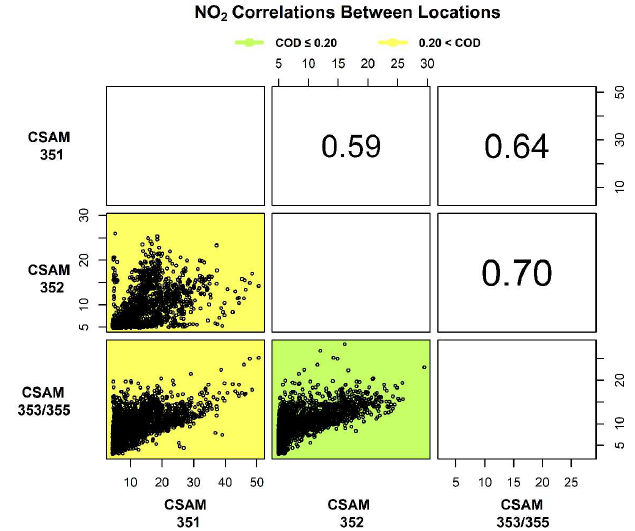
Figure 5. 1 h average NO 2 concentrations were time-aligned in pairwise manner to calculate the Person coefficient (r) and Coefficient of Divergence (COD) between each location. The r values are numerically reported in the upper right and increase in font size with improved correlation. Scatter plots in the lower left visually display the correlations and backgrounds are colored either green (homogenous) or yellow (heterogeneous) to represent the COD values.